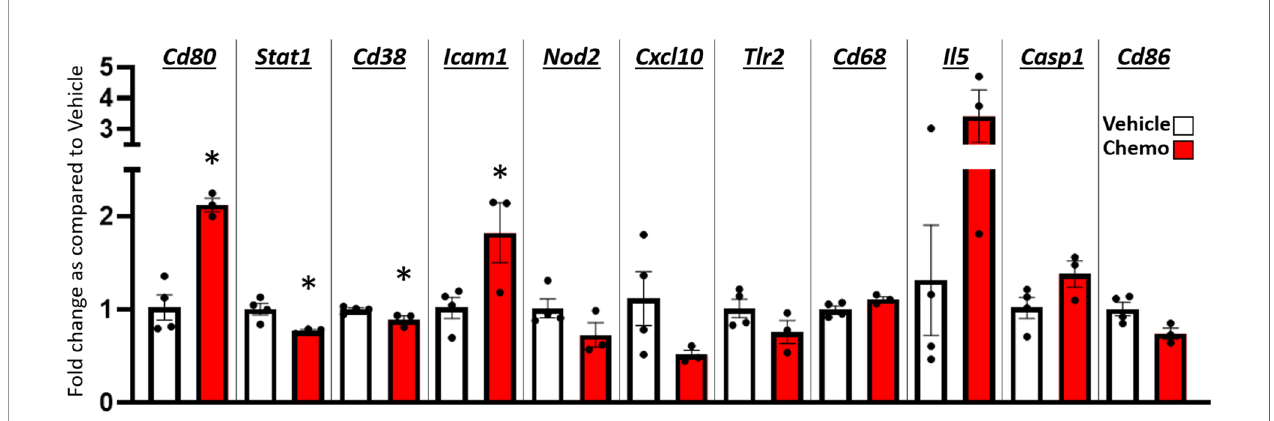
FIGURE 5 | Paclitaxel chemotherapy dynamically alters gene expression in the hippocampus and hypothalamus combined. Relative gene expression shown as fold change as compared to vehicle average of multiple in fl ammation related genes. Paclitaxel n=3, vehicle n=4. Unpaired parametric two-tailed t tests were used for statistical analyses. Nonparametric Mann-Whitney U tests were used when the assumptions of normality and equal variances were not met.